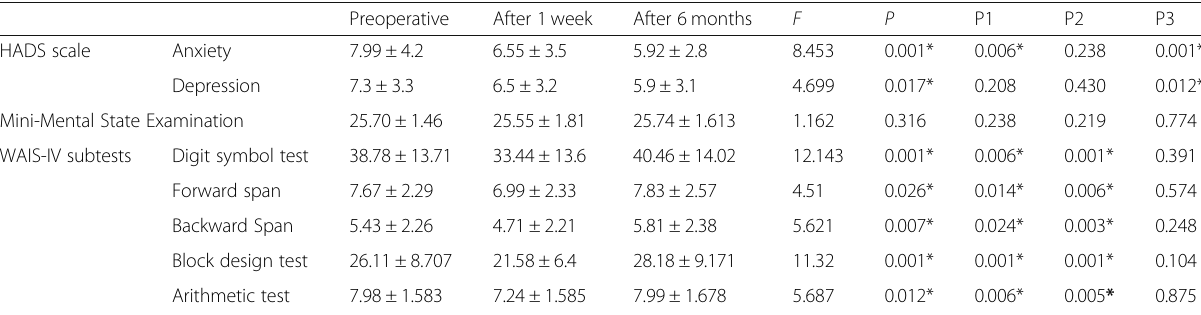
Table 2 Mean value of psychiatric symptoms and cognitive performance at different time points in the